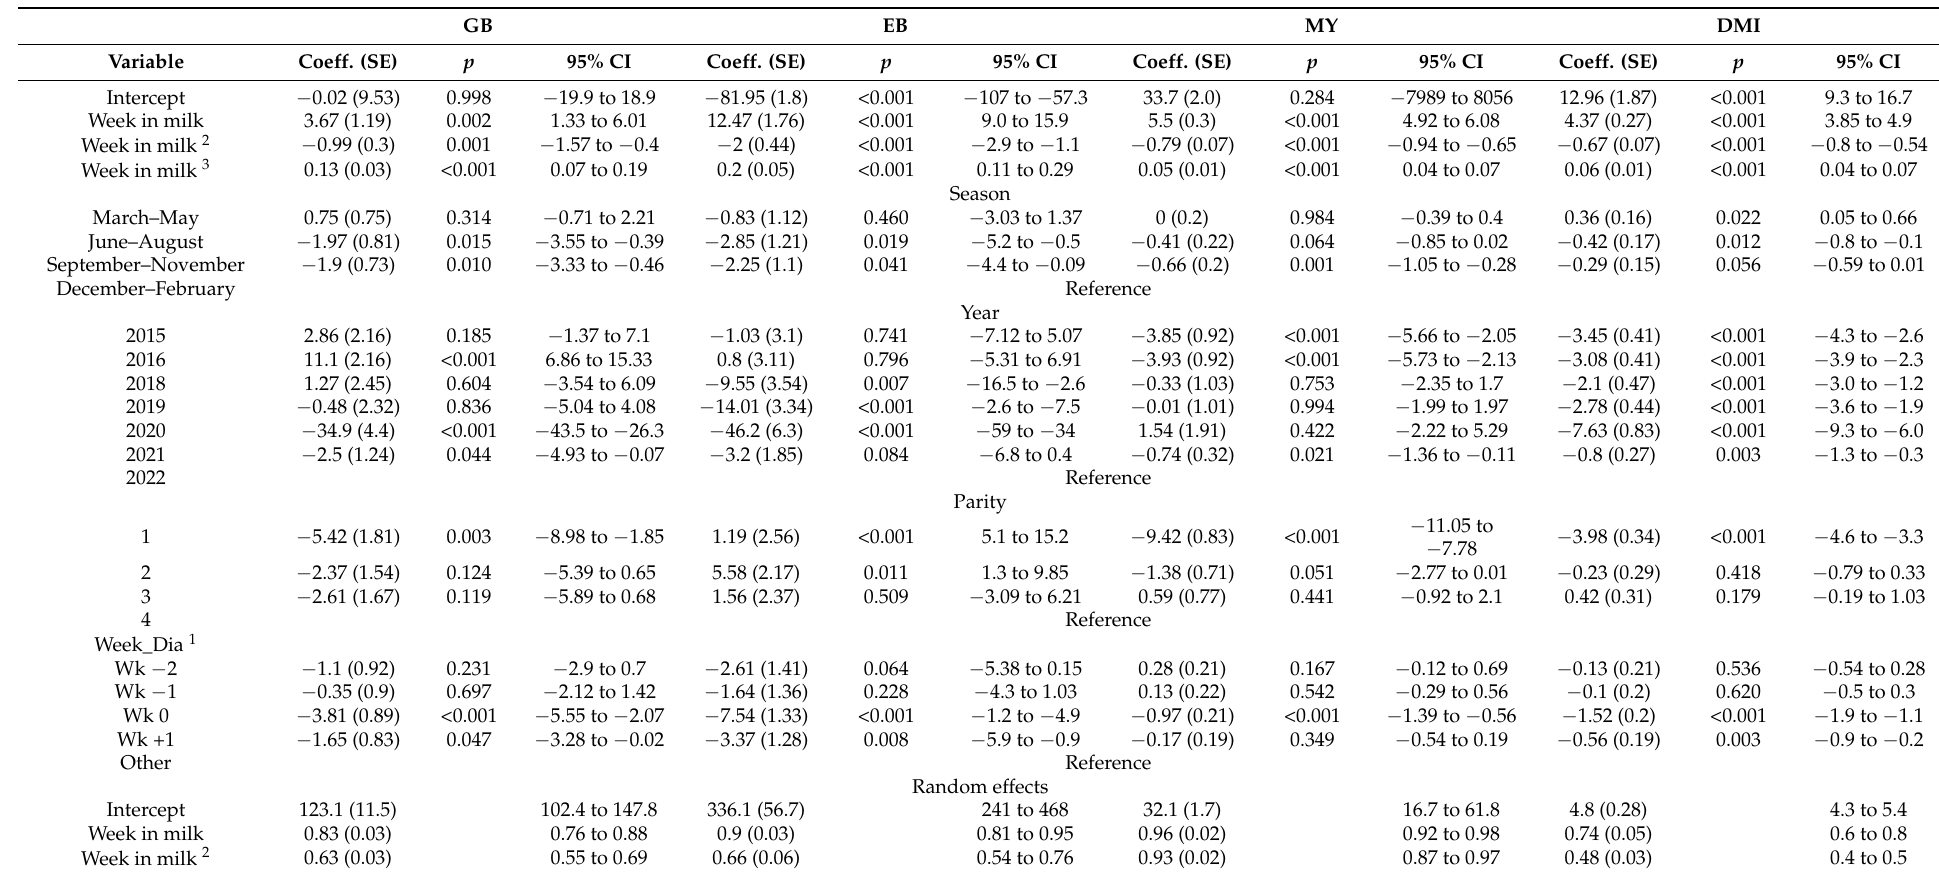
Table A2. Estimated regression coefficients and their standard errors from a mixed linear regression model of factors influencing the weekly means of average